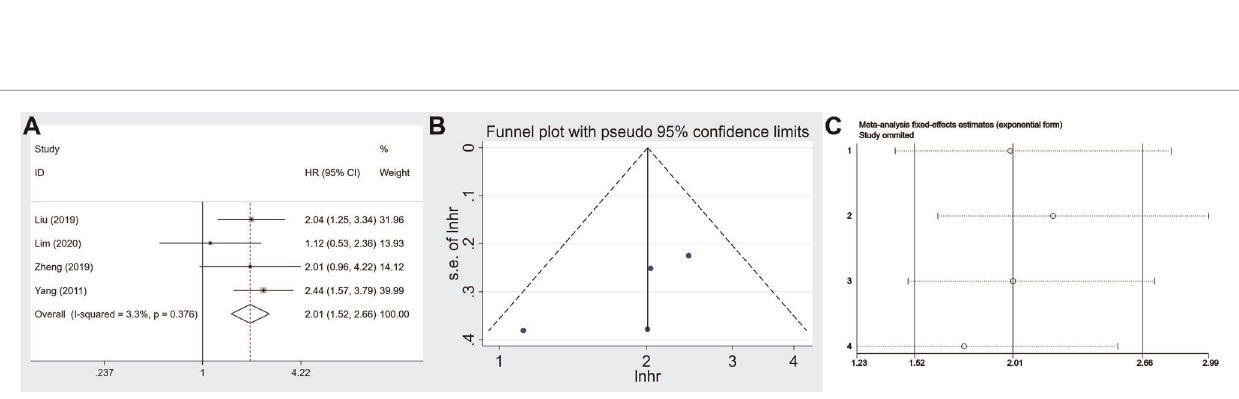
FIGURE 4 | Funnel plots for the association of USP22 expression with clinicopathological parameters: ( A ) gender, ( B ) age, ( C ) tumor size, ( D ) tumor differentiation, ( E ) depth of invasion, ( F ) lymph node metastasis, ( G ) distant metastasis and ( H ) TNM stage.